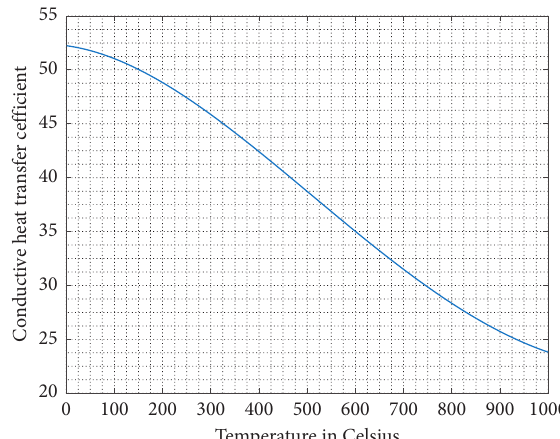
Figure 4: Conductive heat transfer coefficient of base material v/s